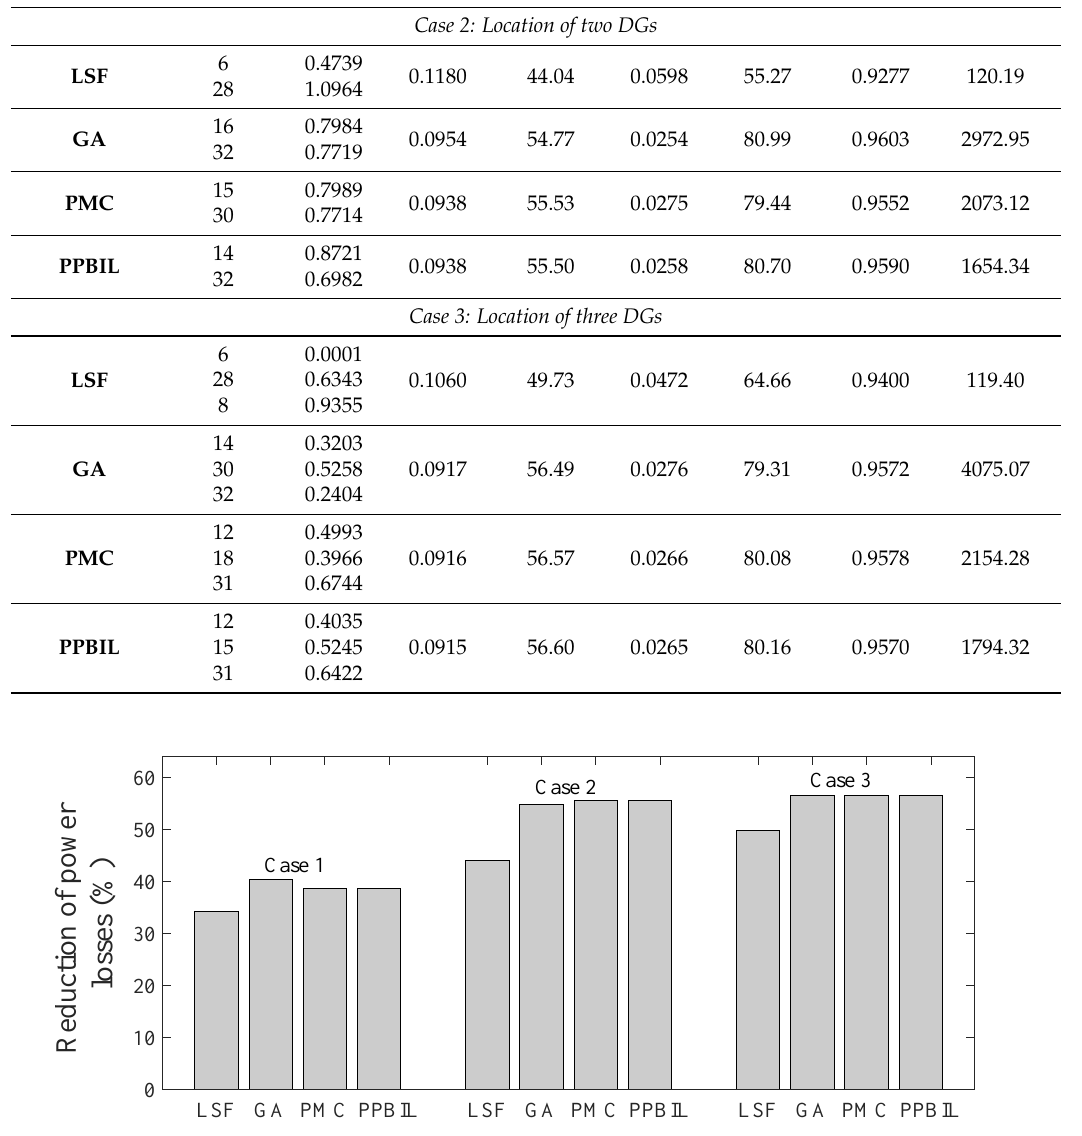
Figure 10. Reduction of power losses in the test system with 33